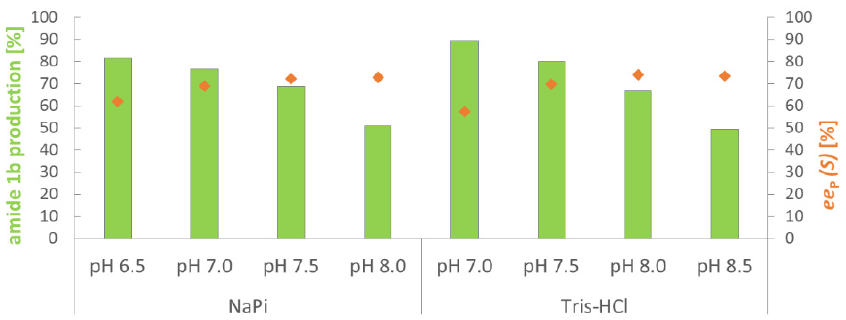
Figure 2. Formation of ( S )- 1b by Gh NHase-CFE at different pH. The orange-colored diamonds indicate the enantiomeric excess. ( R , S )- 1a (50 mM) was treated with 0.64 mg/mL Gh NHase in sodium phosphate or Tris-HCl buffer (100 mM) at 25 °C and 500 rpm.